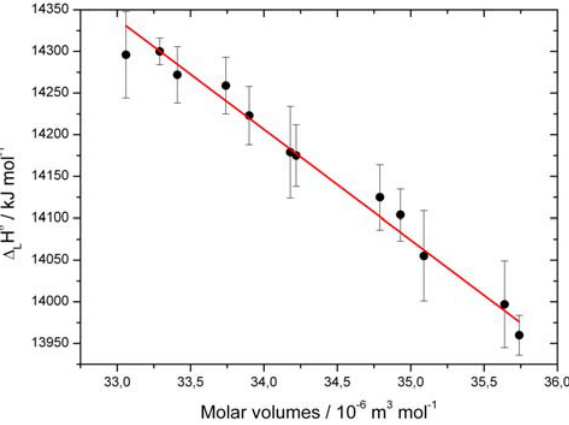
Figure 1. Variation of the lattice enthalpies vs. molar volumes of LnFeO with enthalpies of formation of LnFeO 3